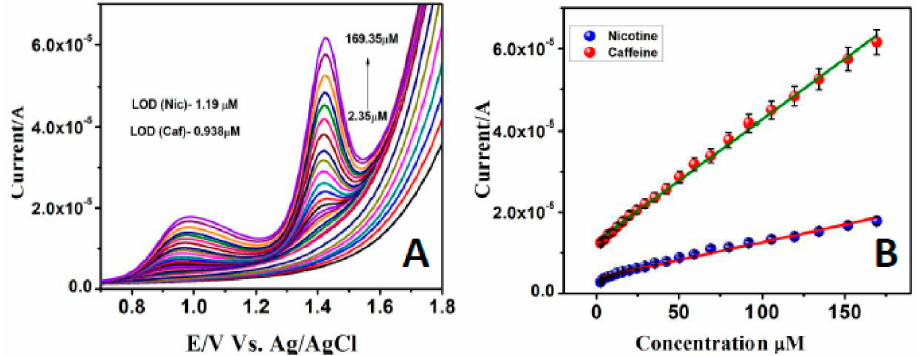
Figure 9. ( A ) SWVs obtained for various concentrations of nicotine and ca ff eine (2.35 to 169.35 µ M) at HA-GN-MWCNT modified GCE in 0.1 M PBS (pH 7.0). ( B ) calibration